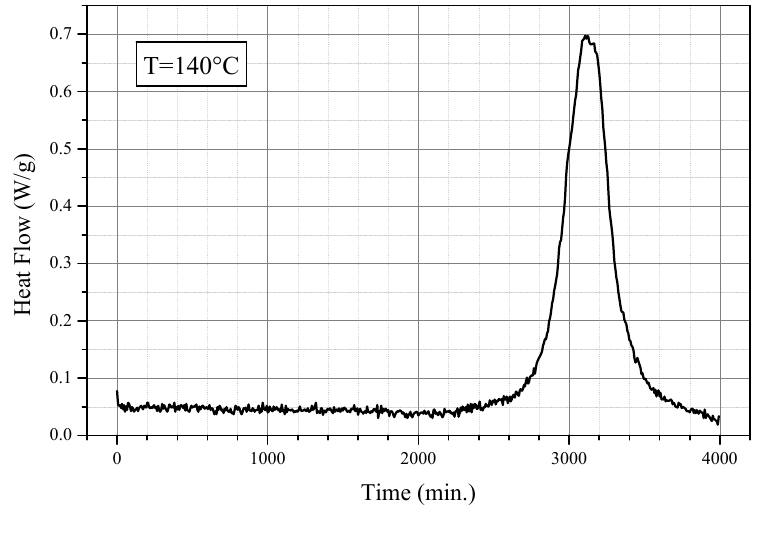
Figure 3. Exothermic behavior observed in isothermal test for ABS powder containing 60% PB.